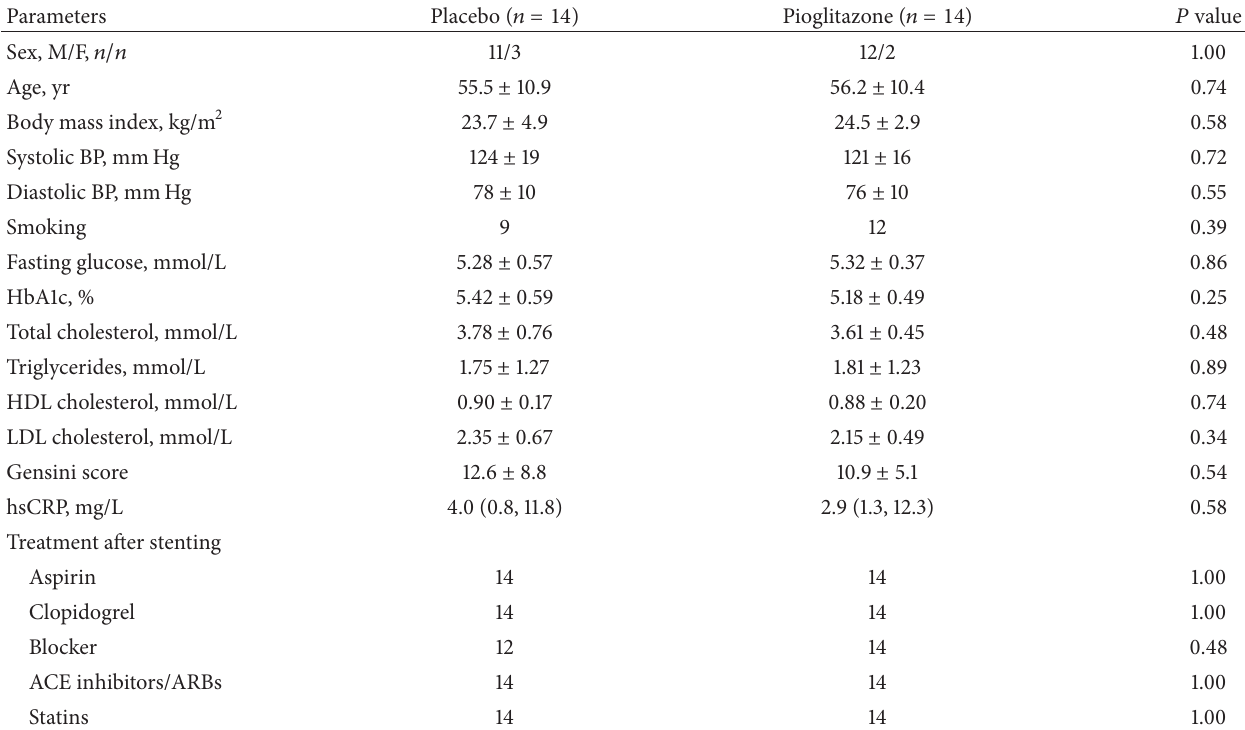
Table 1: Baseline characteristics of the study